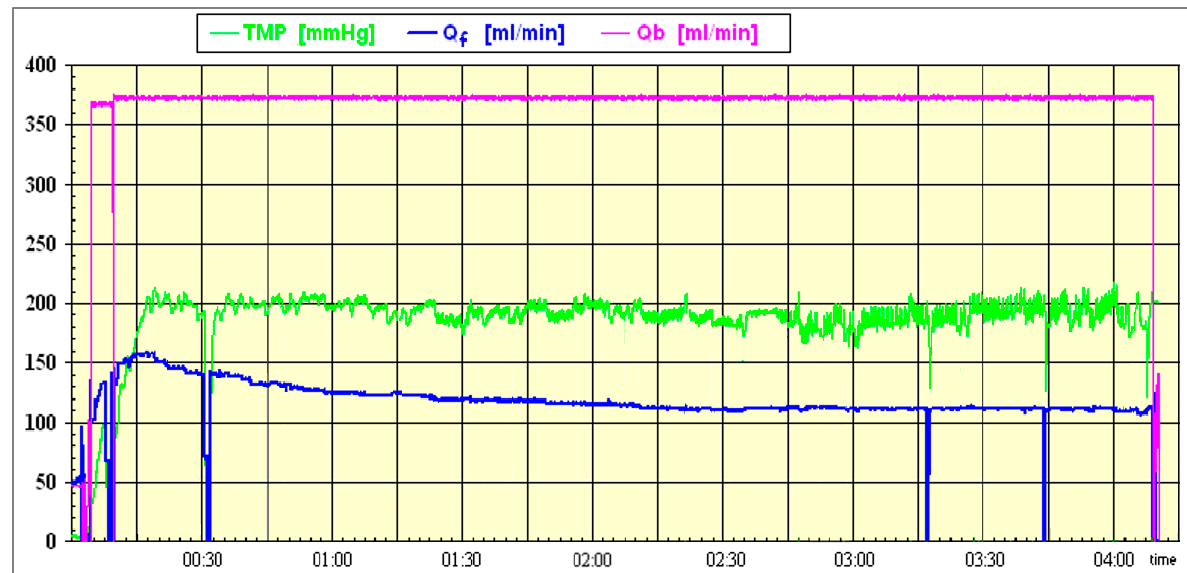
Figure 4. Post-dilution online HDF treatment with control of substitution by AutoSub plus™; the dialyzer used was the FX60 (Fresenius Medical Care).